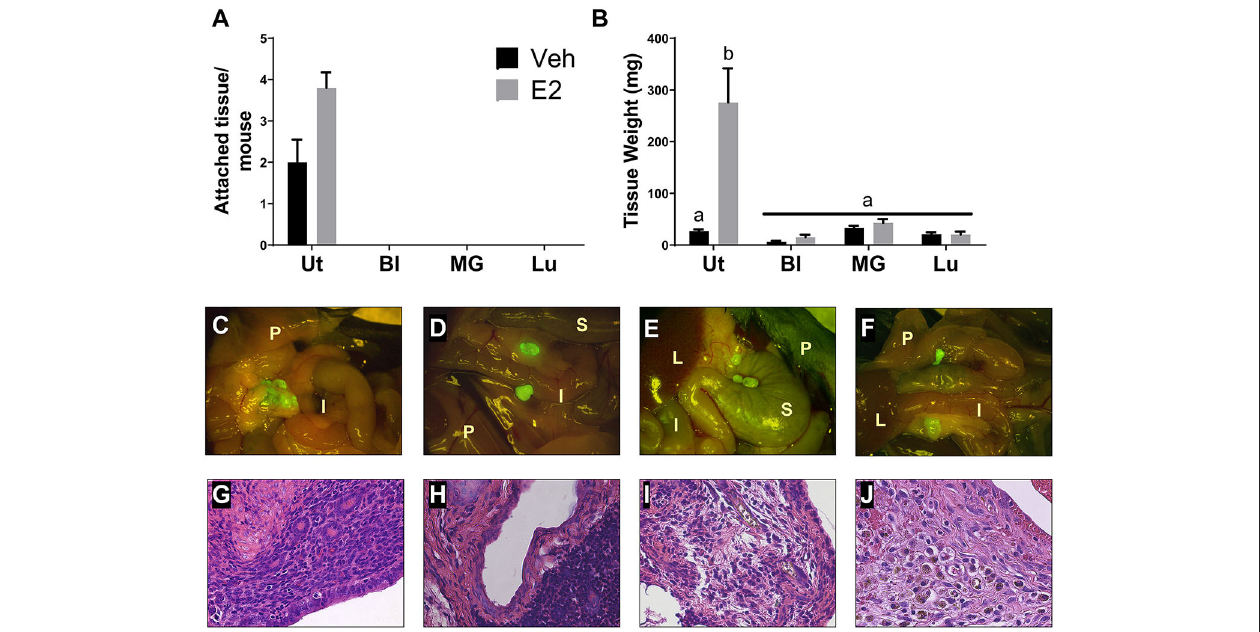
FIGURE 2 | Endometriotic lesions are only formed when uterine tissue is dispersed into the peritoneal cavity. (A) Attached tissue number per mouse. Animals were treated with corn oil vehicle (Veh) or E 2 valerate (2.5 µ g/mouse/week) for 3 weeks. (B) Weight of tissue removed from the peritoneal cavity 3 weeks after tissue transfer. (C–F) Gross appearance of tissues (7.5 × ) with WT uterus (C) , bladder (D) , mammary gland (E) , or lung (F) tissue transfers 3 weeks after initiation. Lesions in C are attached to sites within the peritoneal cavity. Tissues in D–F are free floating throughout the peritoneal cavity and collected together for documentation. I, intestine; P, peritoneal wall; L, liver; S, stomach. (G–J) Histological evaluation (H&E) of lesion/unattached tissues ( × 400) with WT uterus (G) , bladder (H) , mammary gland (I) , or lung (J) tissue transfers 3 weeks after initiation. Representative examples are E 2 treated. Letters different than each other are statistically significant, p < 0.05, Two-way ANOVA, Tukey’s multi-comparison test. Ut, uterus; Bl, bladder; MG, mammary gland; Lu,